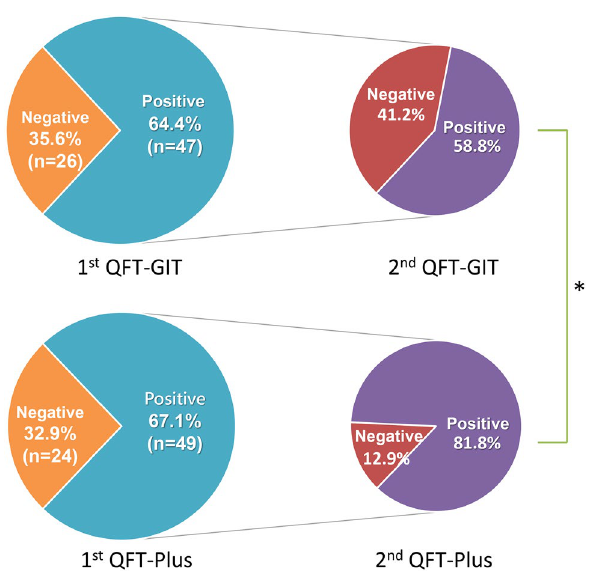
Figure 2. The results of the second follow-up QuantiFERON-TB tests for the subjects with positive results on the first paired QuantiFERON-TB Gold In-tube (QFT-GIT) and QuantiFERON-TB Gold plus (QFT-Plus), respectively. *p value was 0.040 for positive 2nd QFT-GIT versus